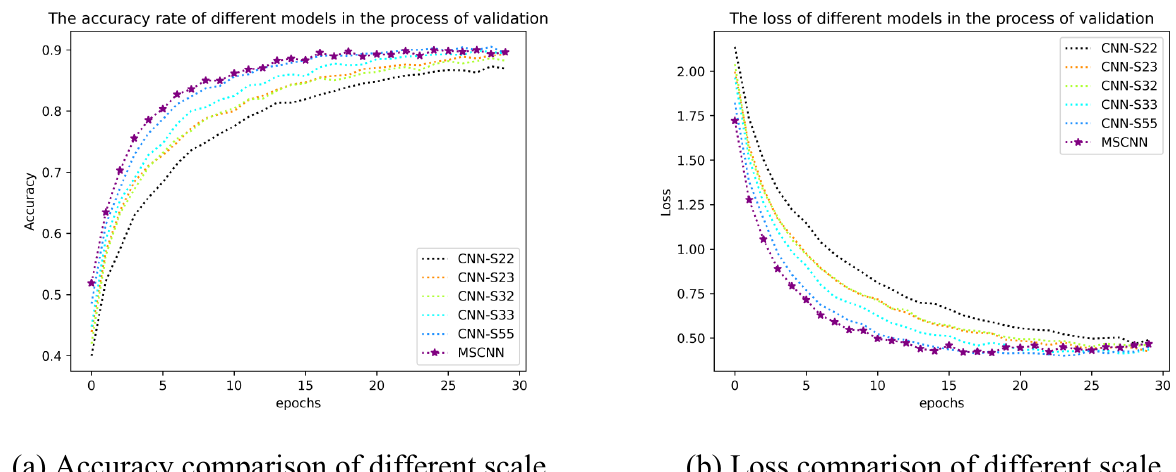
Figure 9. Comparison of MSCNN model results at different scales in the validation set.